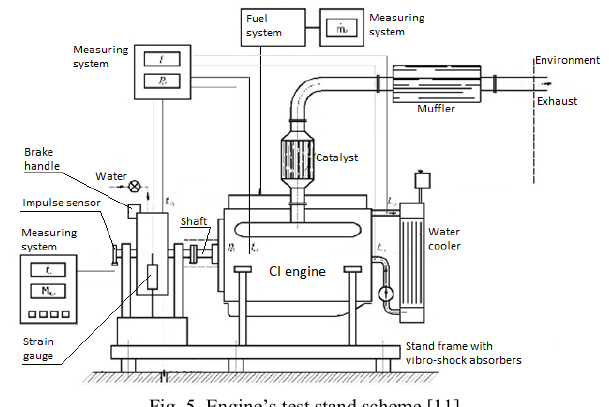
Fig. 5. Engine’s test stand scheme